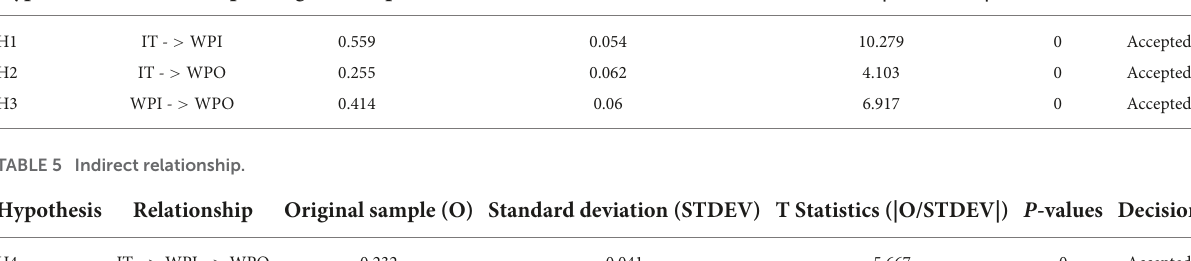
TABLE 4 Direct relationship.